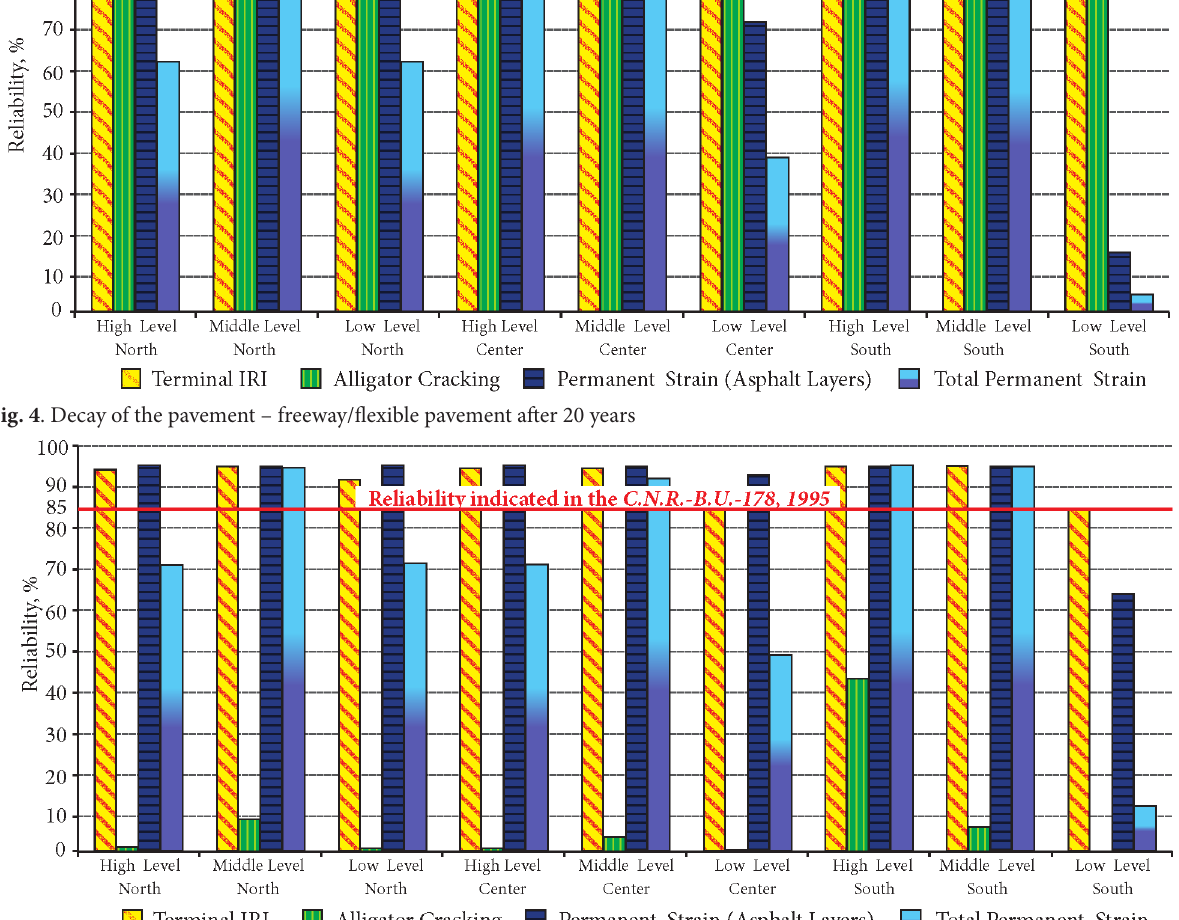
fig. 5. Decay of the pavement – highway/flexible pavement after 20